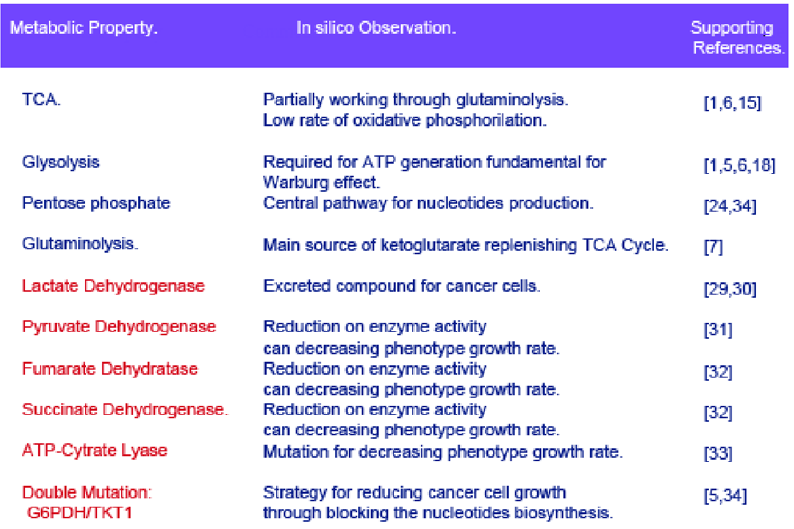
Figure7. Physiological assessment of insilico interpretations. A proper assessment of in silico results is required to ensure properreconstruction. Ten proofs were used here to evaluate the physiological consistency of the results from constraint-based modeling. In sequential order, columns indicate the metabolic property computationally analyzed, in silico predictions and its consistency with some representative references. The blue text in column 1 represents metabolic pathways, while red lines indicate the effects that enzyme mutation has on cancer cell growth.